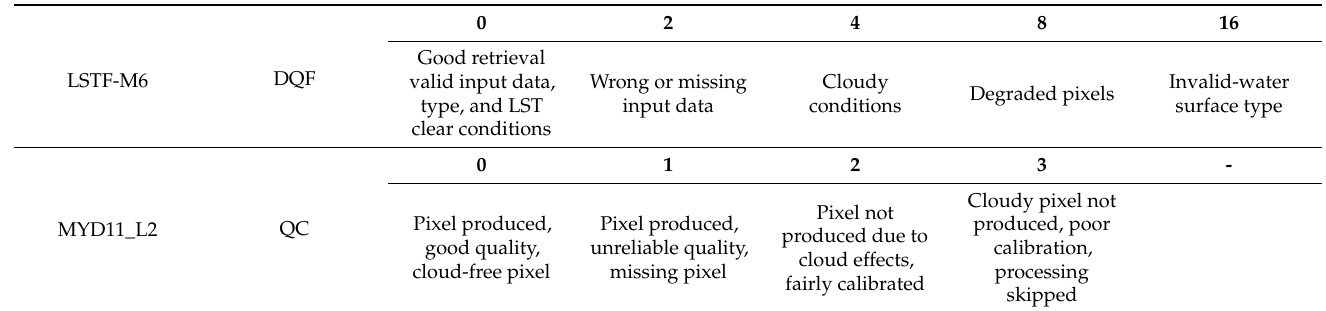
Table 2. LST Data Quality